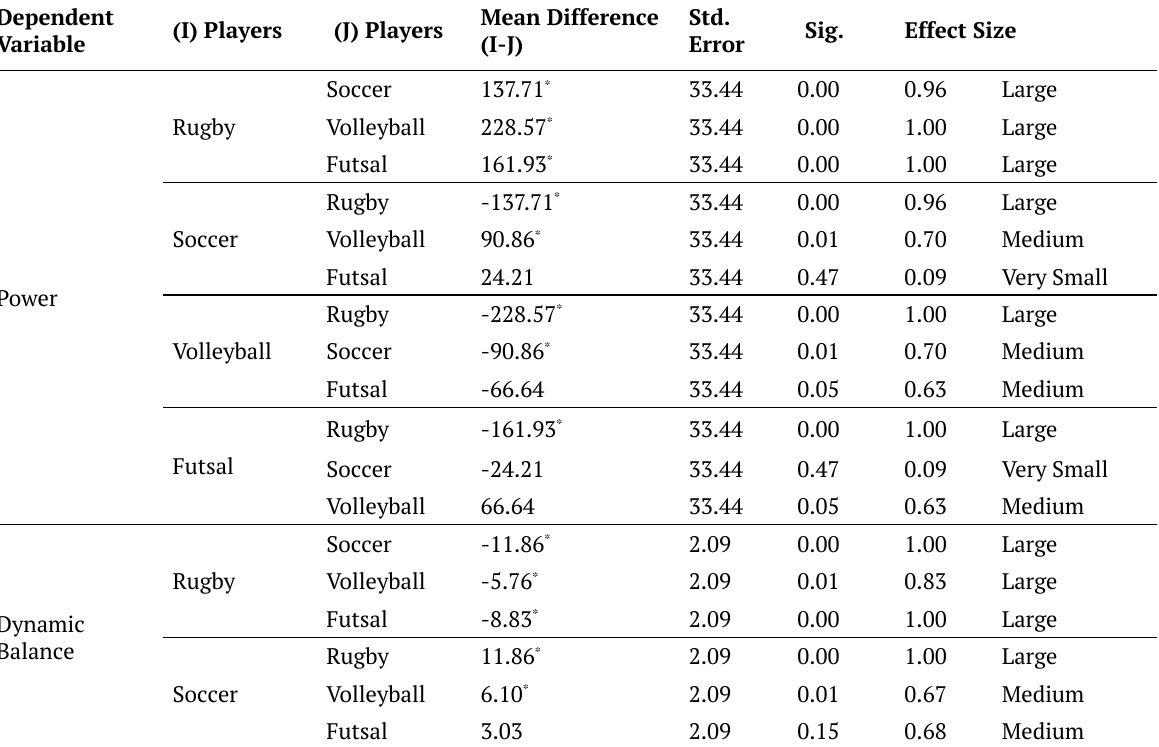
* - The mean difference is significant at the 0.05 level. Table 5. Post-Hoc (LSD) and effect-size Analysis of physical performance output values of athletes from random intermittent dynamic type